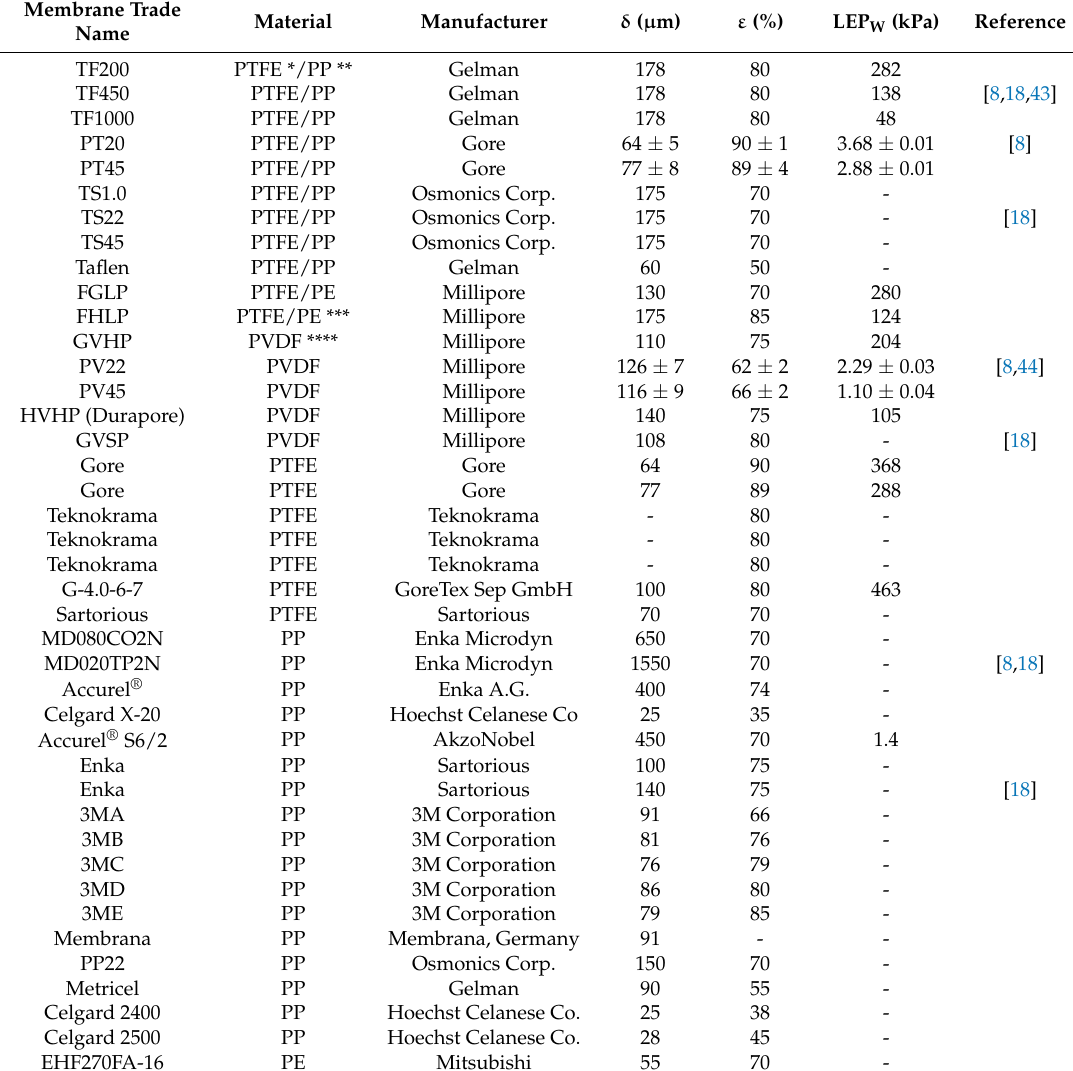
Table 3. Commercial membranes applied in MD (membrane thickness, δ ; porosity, ε ; liquid entry pressure of water,